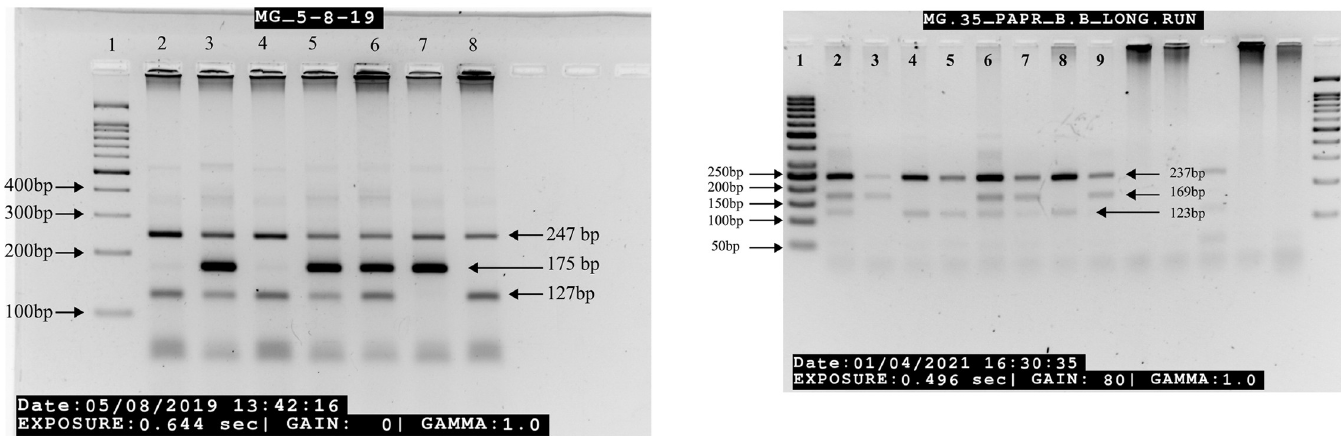
Fig 2. Amplified product on agarose gel (3%). A. lane 2 to 8 showed genotypes of SNP rs3844283 where two bands indicating homozygous genotype and three bands indicates heterozygous genotypes. Lane 1 carrying 100bp marker, Lane 2 and 8 indicating C/C wildtype genotype, Lane 3 to 6 having heterozygous C/G genotype with three bands and Lane 7 showing G/G mutant genotype. B. Lane 1 to 9 from left showed genotypes of SNP rs708035 where two bands indicating homozygous genotype Lane-1 carrying 50bp marker, lane 2, 6 and 7 indicating Heterozygous A/T genotype with three bands, lane 3 and 9 showing homozygous mutant genotype T/T, lane 4,5 and 8 carrying homozygous wildtype genotype